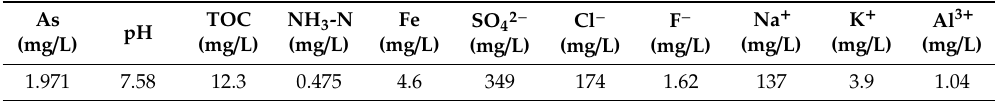
Table 1. The raw ground-water quality